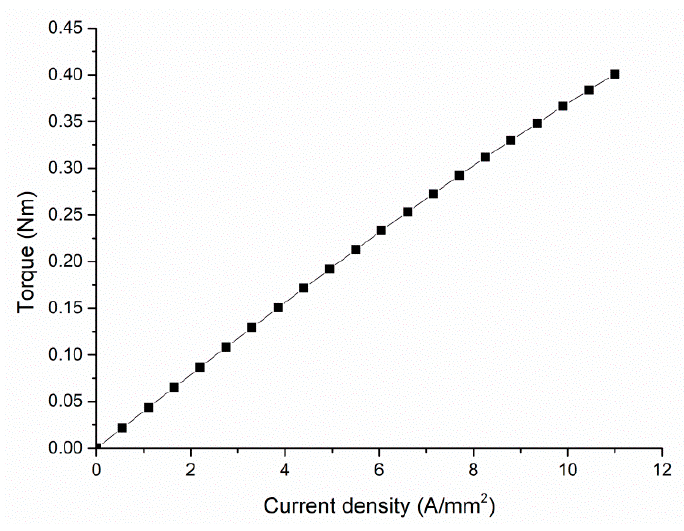
Figure 9. EM torque with the variation of current density.